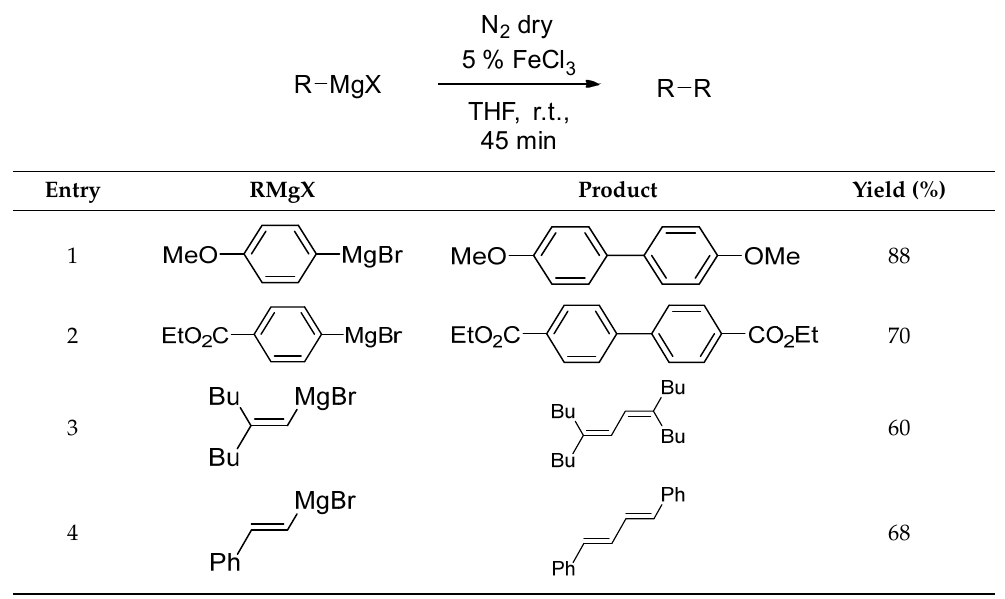
Table 1. Homocoupling of organomagnesium compounds in the presence of FeCl 3 .